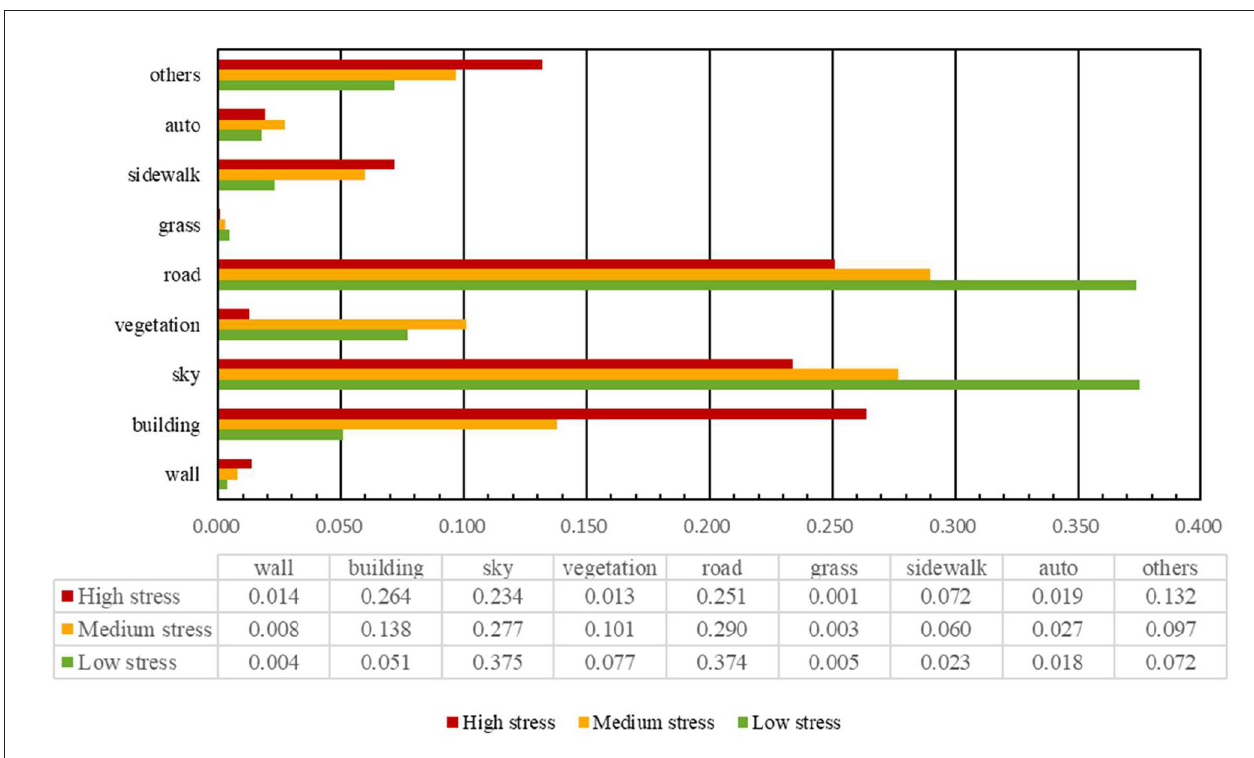
FIGURE 12 | Proportional coverage of visual elements in images with low, medium, and high perceived